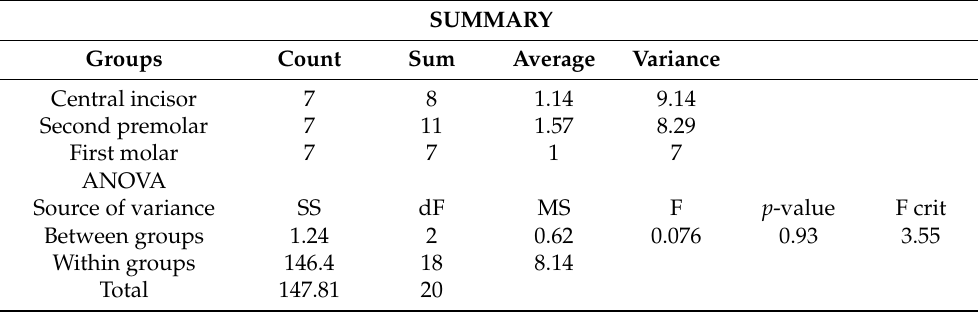
Table 3. Comparison between groups (single-factor